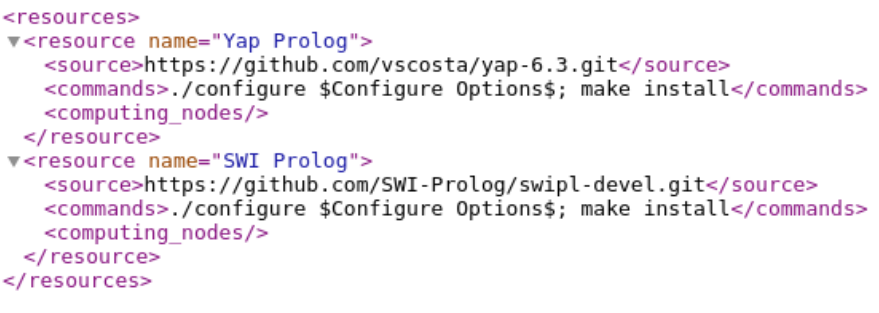
Figure 8. An example of the resources.xml